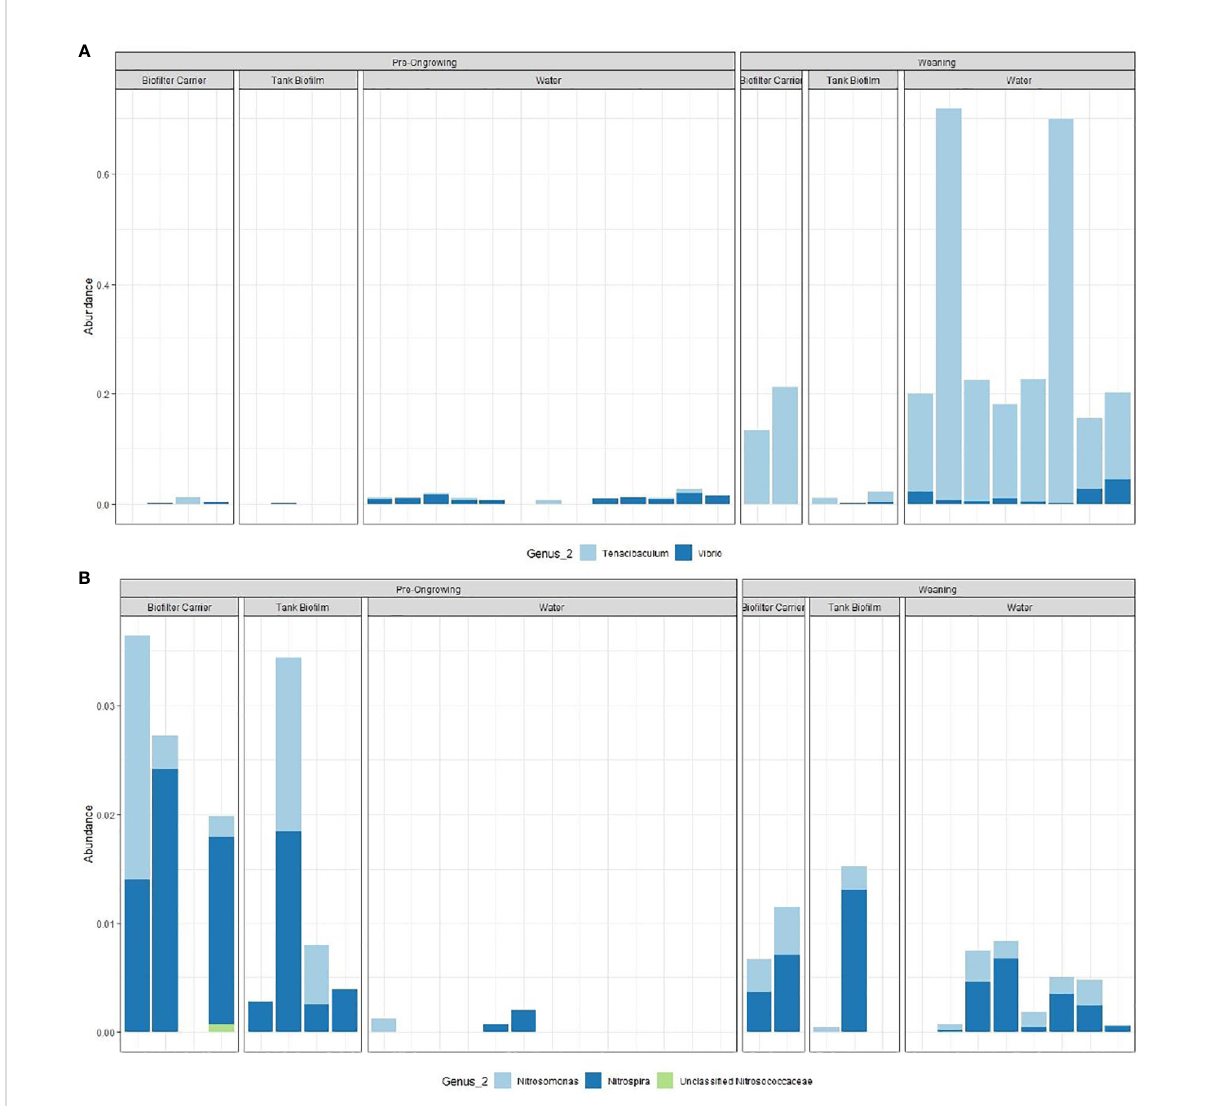
FIGURE 2 Relative distribution of the functional groups, genus associated with nitri fi cation (A) , the ammonia oxidizing bacteria (AOB, Nitrosomonas, Unclassi fi ed Nitrosococcaceae), nitrite oxidizing bacteria (NOB, Nitrospira) and ammonia oxidizing archaea (AOA, Candidatus Nitrosopumilus); and genus with potentially pathogenic activity ( B , Vibrio and